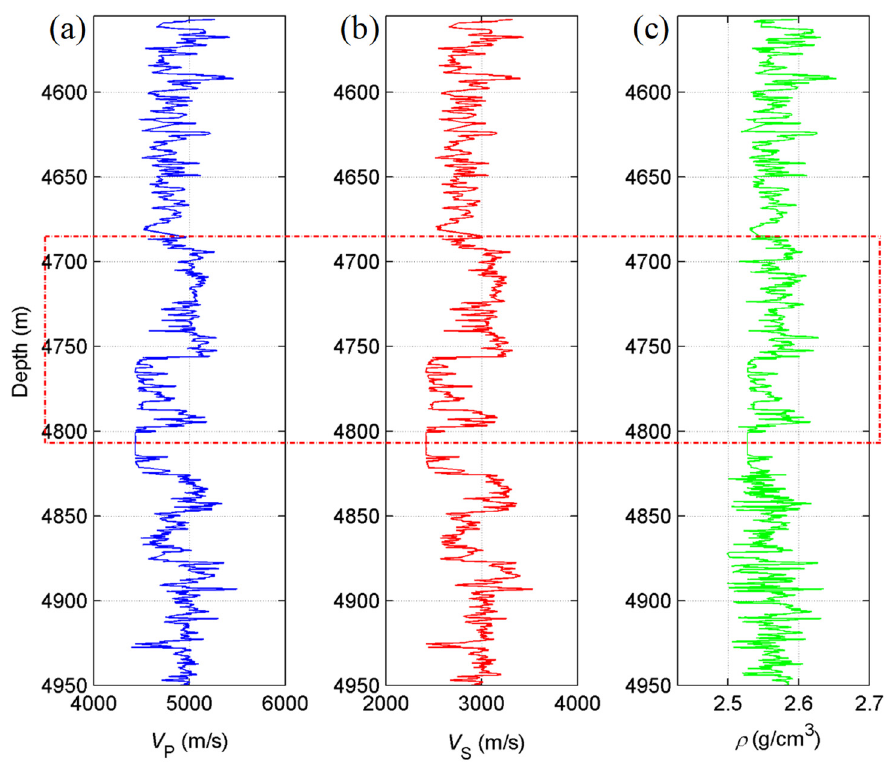
Figure 2. Log profiles of Well P. ( a ) P-wave velocity, ( b ) S-wave velocity, and ( c ) density. Table 1. Seismic properties, corresponding to the sandstone model of the Xujiahe Formation.